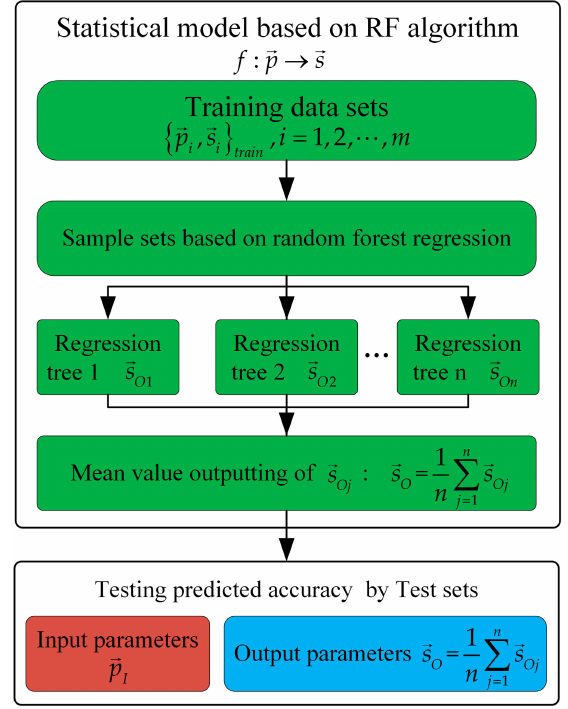
Figure 5. The parameters prediction flow chart of random forest